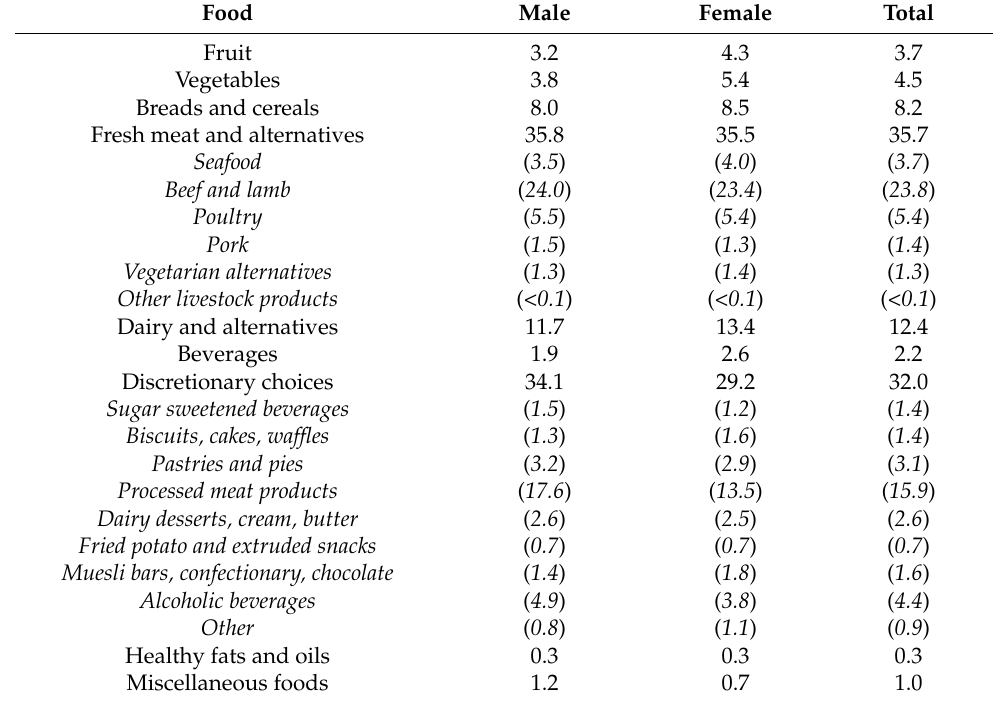
Table 1. Contribution of different foods (%) to the climate footprint of Australian adult daily diets ( n = 9341) assessed using the Global Warming Potential Star (GWP*) climate metric. Food groups are as defined by the Australian Dietary Guidelines